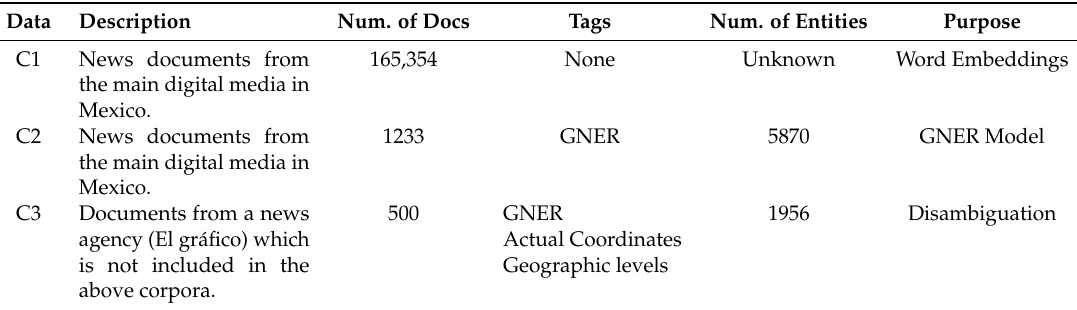
Table 2. Corpora